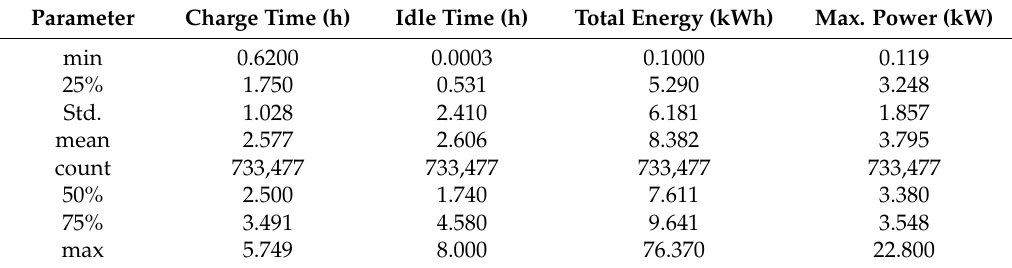
Table 2. Dataset summary of numeric and target variable considered (before scaling or test split).